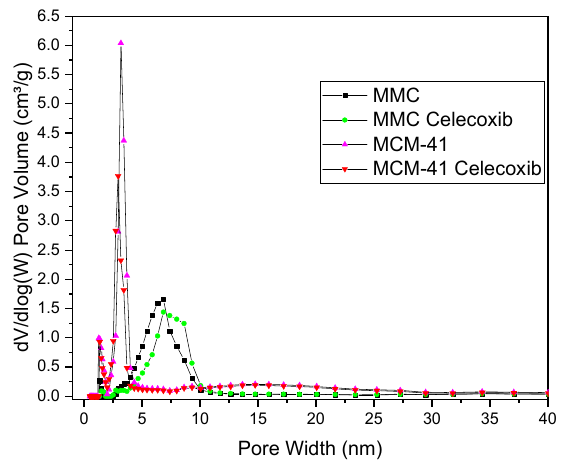
Figure 2. Pore size distribution of unloaded and drug-loaded MMC and MCM-41.